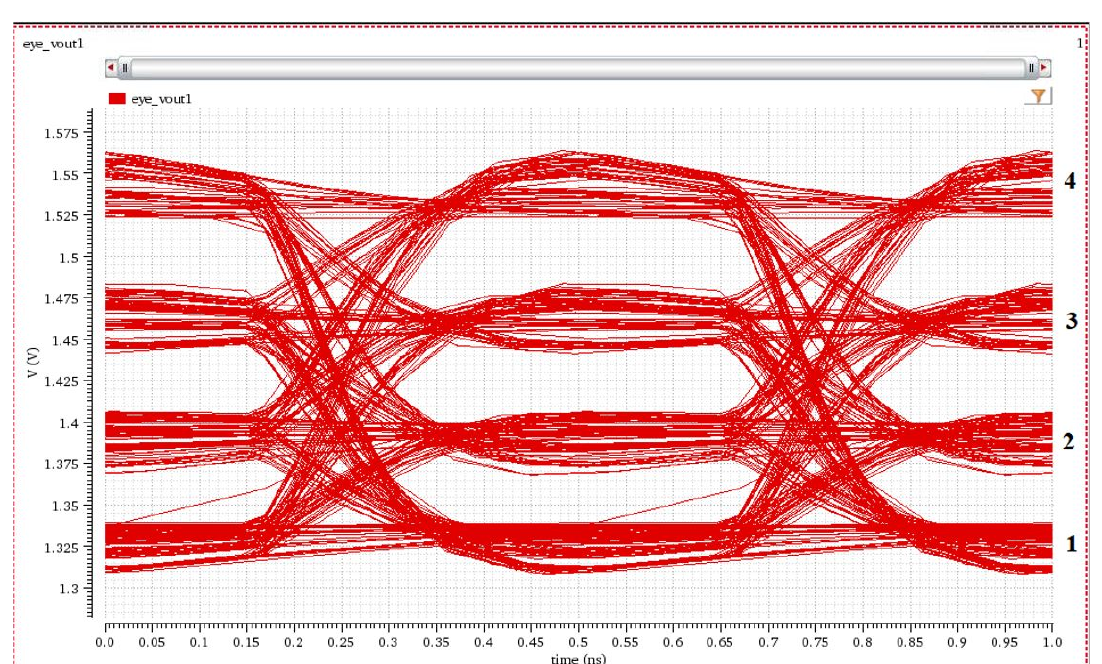
Figure 18. Eye diagram AFE for PAM4 signal.